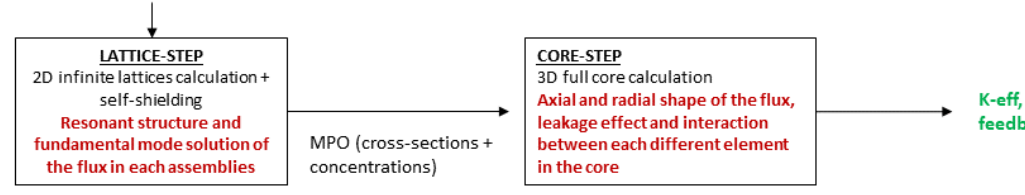
Figure 3. 2-step neutronic scheme